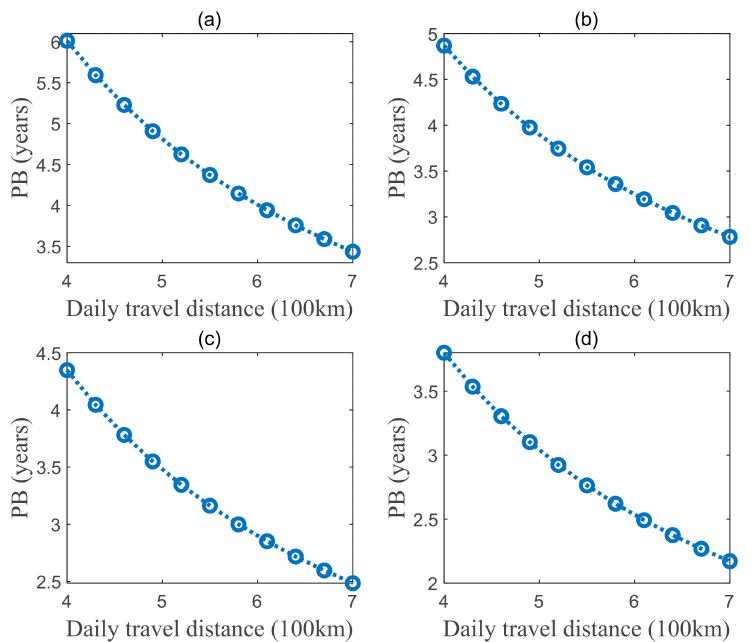
Figure 9. Evolution of the payback period (PB) vs. daily travel distance when the vehicle works for 255 days each year, fuel price is EUR 1.5/L, and the working fluid is ( a ) R245fa, ( b ) R245ca, ( c ) R601a, and ( d ) RC490,